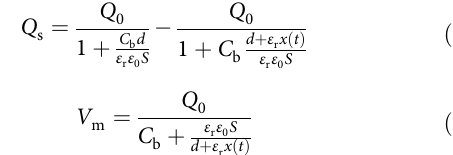
Supplementary Fig. 8. The following equations can brie fl y